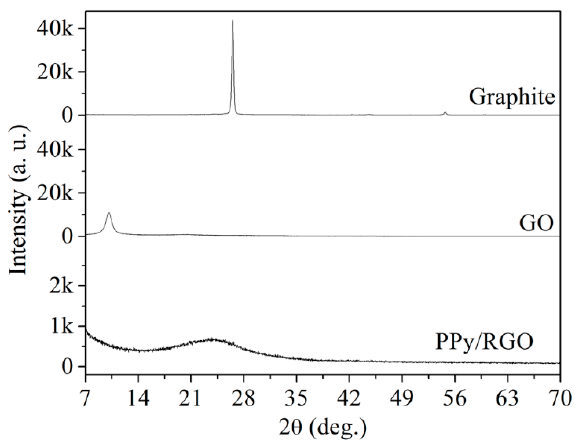
Figure 7. X-ray diffraction (XRD) patterns for graphite, GO, and PPy/RGO.